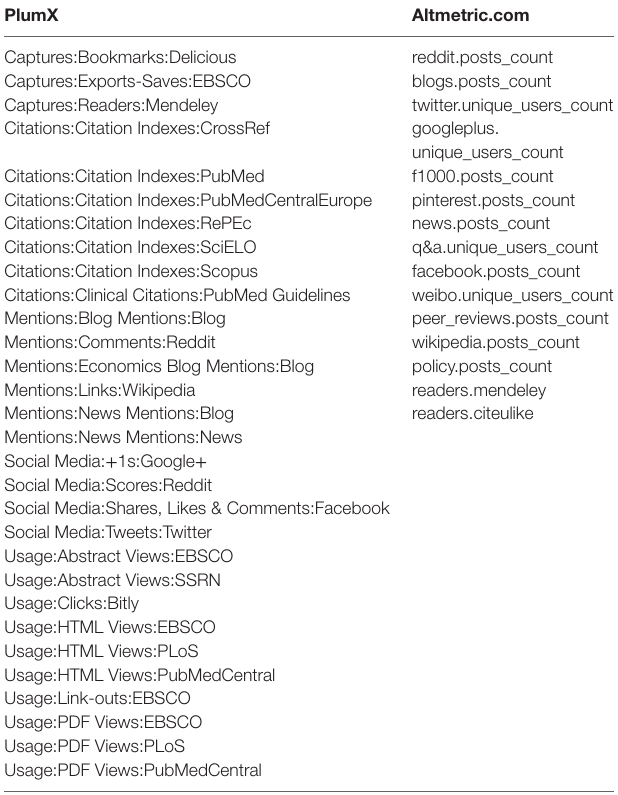
Table 4 | Full list of signals for journal articles available in Altmetric.com and PlumX ( n = 3,399; publication years < 2016). PlumX altmetric.com